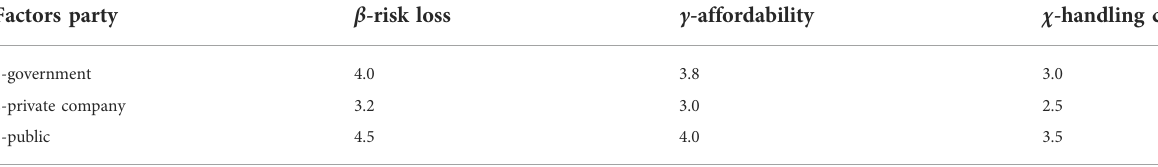
TABLE 3 Sharing willingness score of the government, private company, and public.